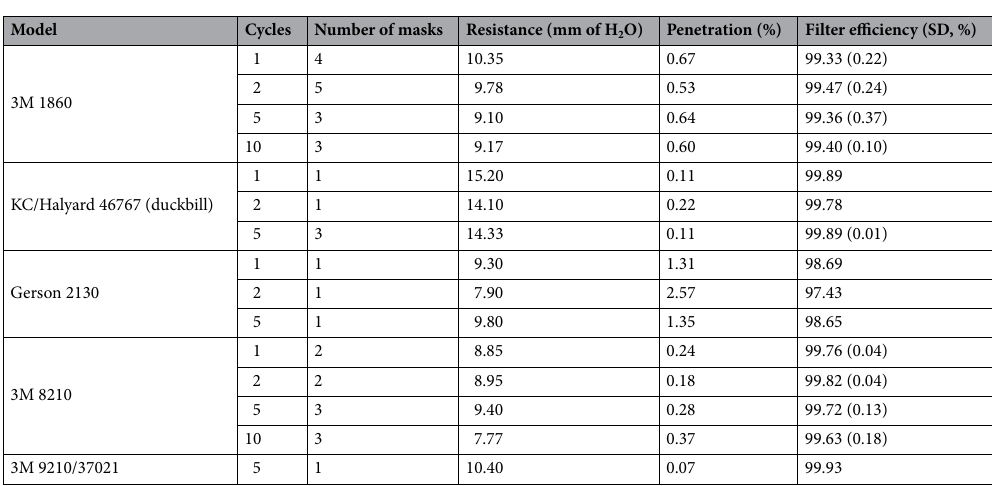
Table 3. Results from ICS Laboratories on instantaneous filtration efficiency according to NIOSH standard Procedure No. TEB-APR-STP-0059 (the flow rate was 85–86 LPM). Each row represents data from one to five N95 masks of a particular model and data are reported as the average for all tests that were performed. In contrast to the data in Table 2, each mask was measured only once and standard deviations are therefore reported only when the number of masks was greater than